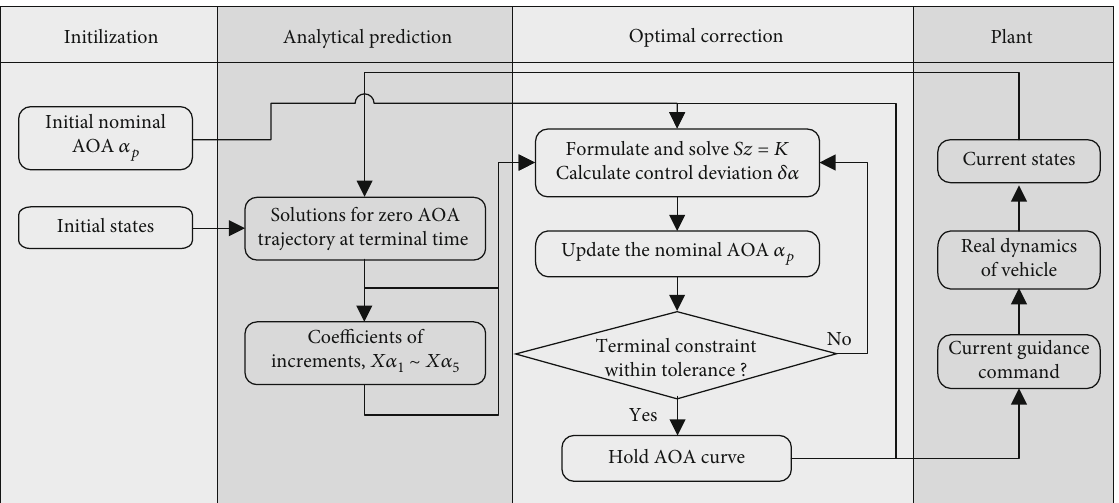
Figure 3: Flow chart for implementing the proposed guidance law.